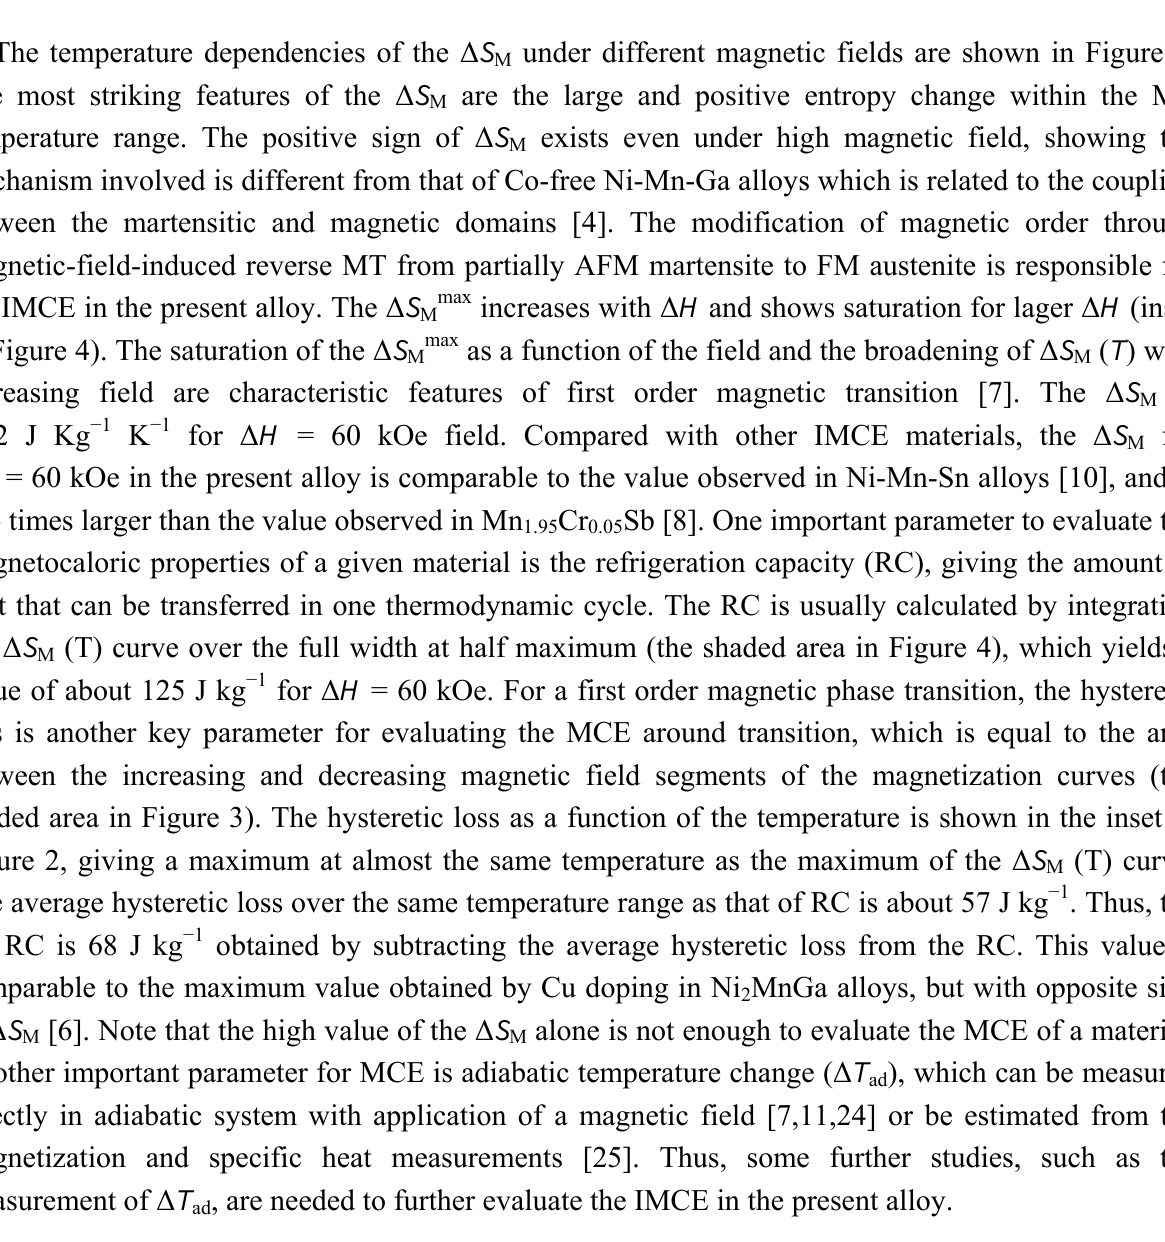
Co Mn Ga around the MT temperature range. 1.68 0.32 1.20 0.80